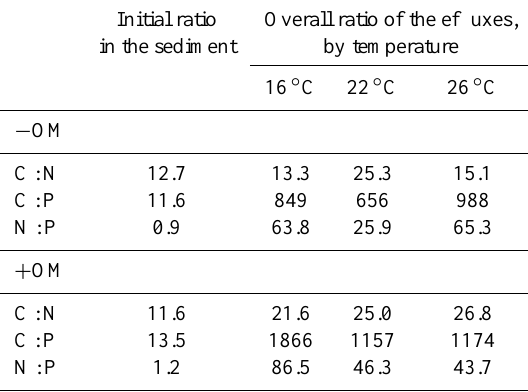
Table 4. Initial C:N:P ratios of the organic matter in the sediment, estimated from particulate organic carbon, total nitrogen and total phosphorus and overall C:N:P ratios estimated from nutrient and total CO 2 flux over the experimental period. C and total CO 2 flux cor- 4 data were reported in Sanz-Lázaro et al. (2011b). See notes below it 4 Table 1 for explanation of